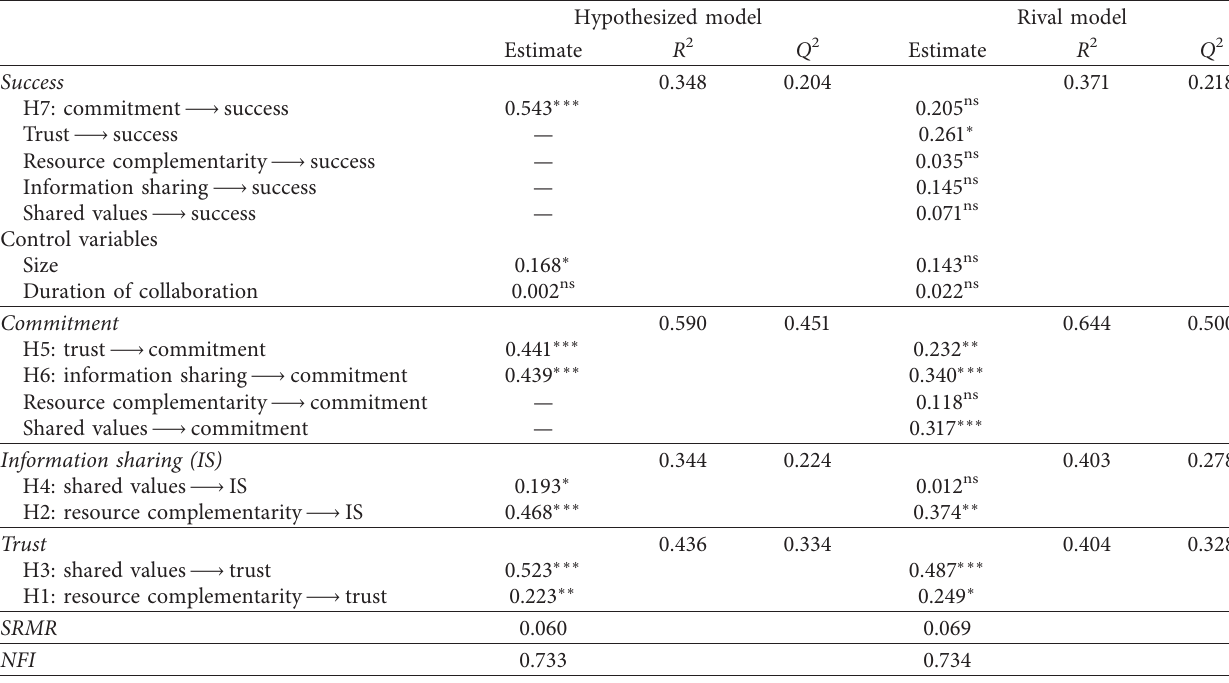
Table 13: PLS analysis results—structural models.